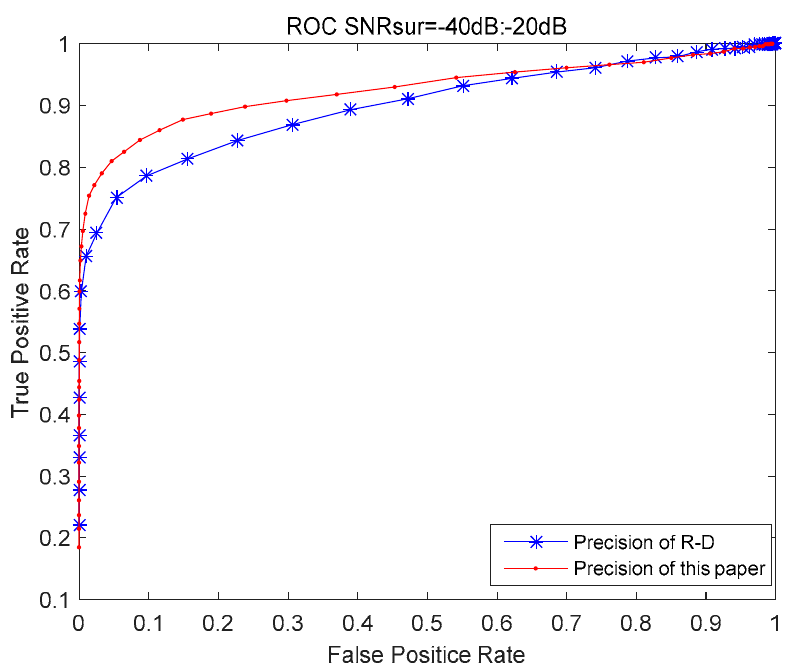
Figure 7. Comparison of ROC curve without reference noise ( N = 10 4 ).